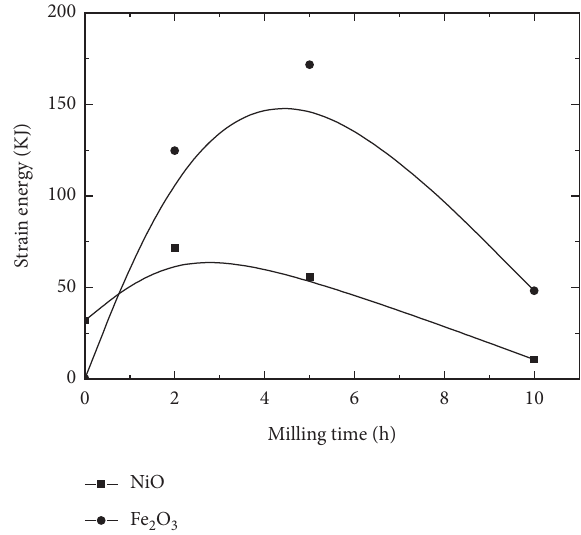
Figure 9: Strain energy in the milled